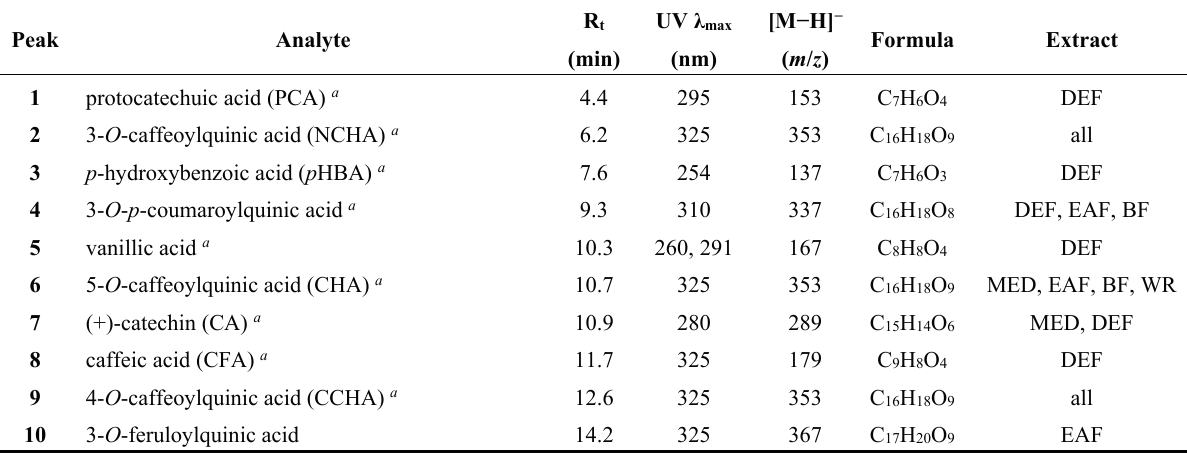
Table 3. Phenolic analytes detected in G. procumbens leaf extracts by UHPLC-PDA-ESI-MS 3 .